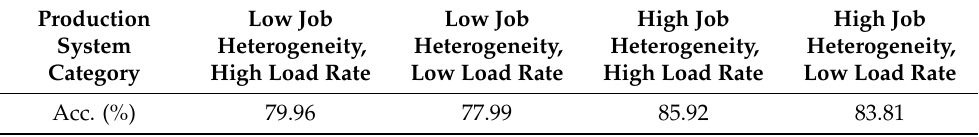
Table 10. Classification model accuracy results.